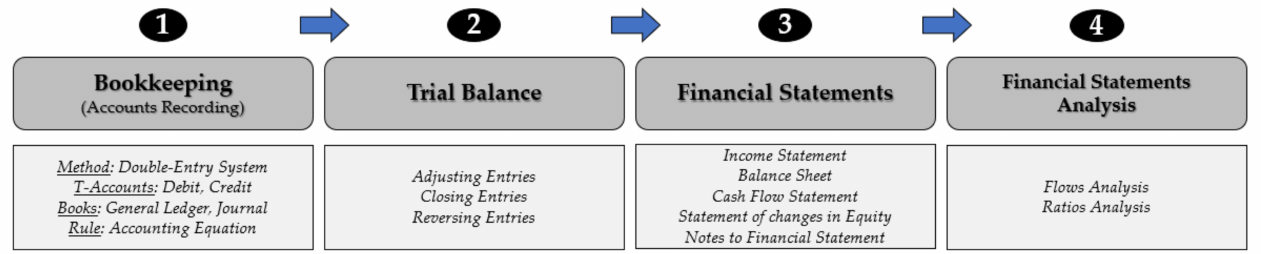
Figure 1. The Accounting